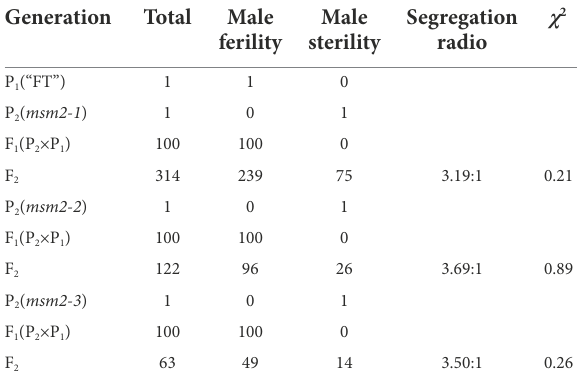
TABLE 1 Analysis for the genetic characteristics of the mutants msm2-1/2/3.